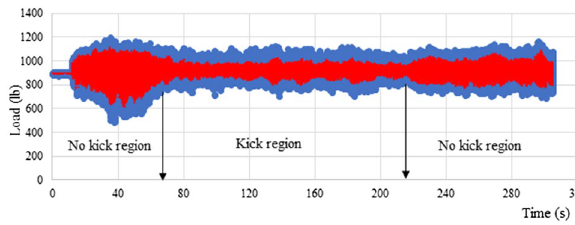
Fig. 7 Effects of gas kick on WOB for experimental